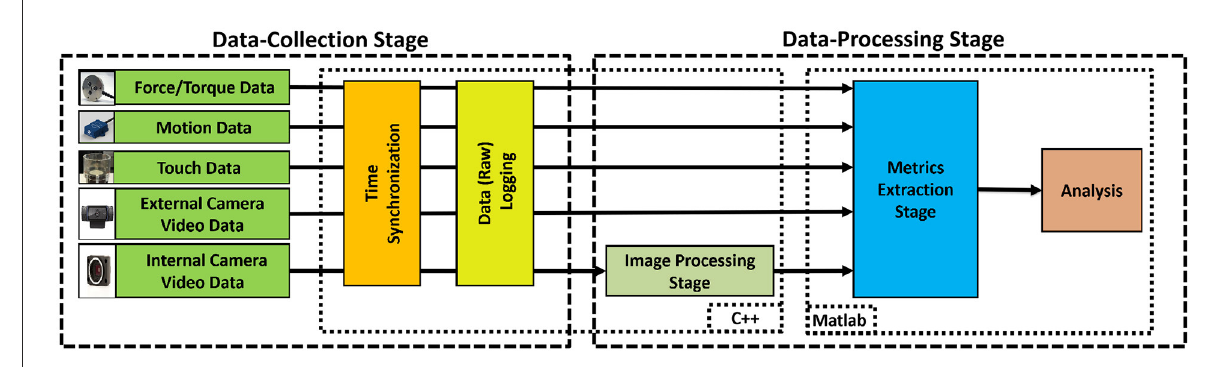
FIGURE4 System process flow-chart, consisting of two stages. In the Data Collection Stage, raw data from multiple sensors were synchronized and logged. In the Data Processing Stage, the collected data were used to extract metrics for suturing